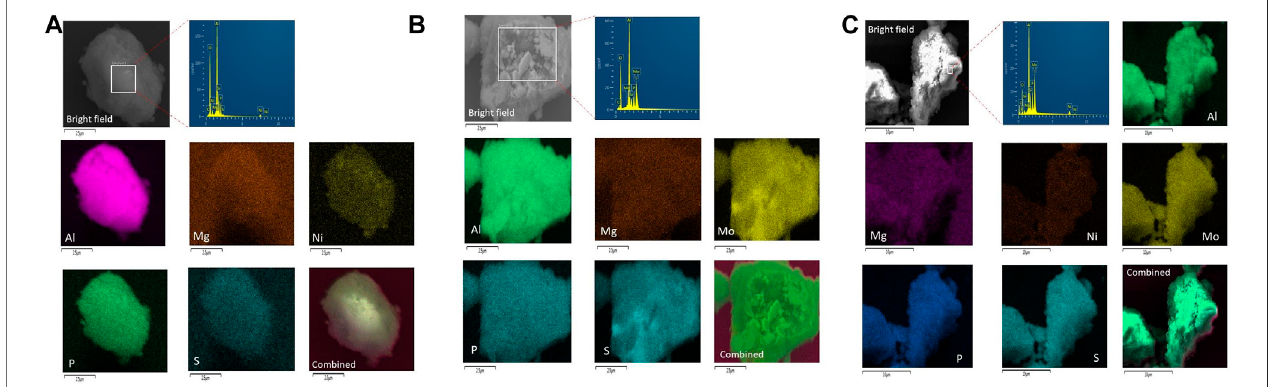
FIGURE6 | (A) EDX elemental mapping ofNi, Al, O, P, Mg, and Sover the NiP-S/ γ -Al 2 O 3 -MgOcatalyst. (B) EDX elemental mapping ofMo, Ni,Al, O, P, Mg, and S over the MoP-S/ γ -Al